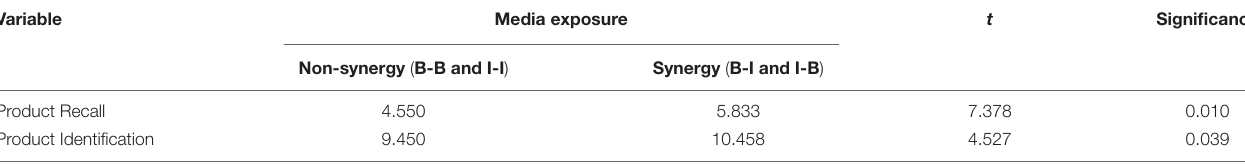
TABLE 6 | Comparison of non-synergistic stimulation and synergistic stimulation in the non-questioning condition.